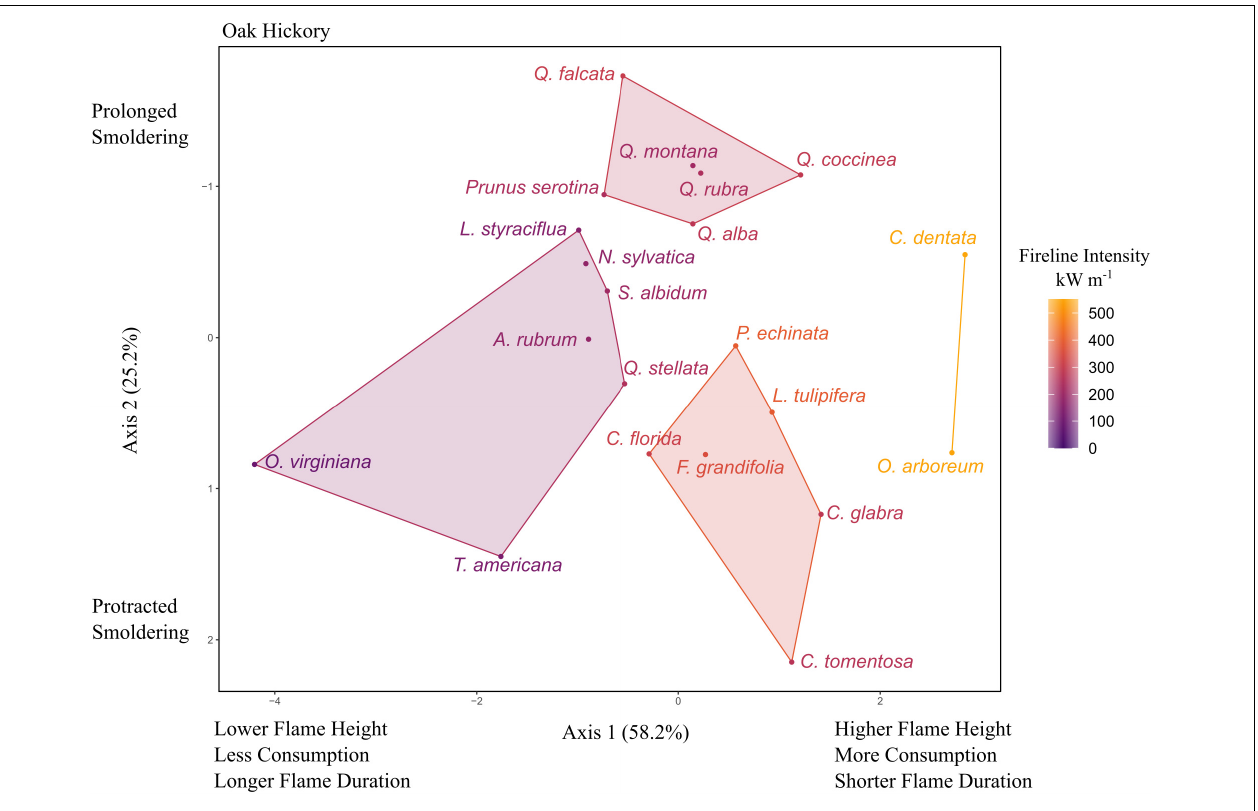
FIGURE 3 | Principal components analysis (PCA) for flammability of tree litter in oak-hickory uplands of the southeastern United States. Axis 2 was inverted to be consistent with the other figures (increased smoldering on the top). Species codes and mean values listed in Table 1 and Supplementary Table 1